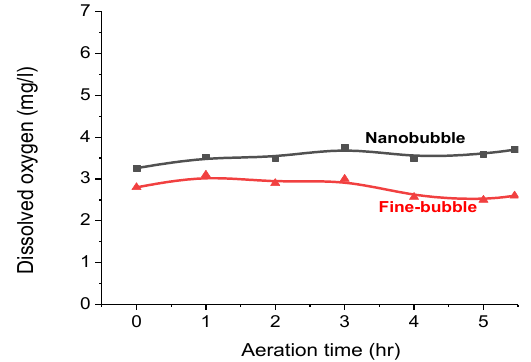
Fig. 4. Changes in Dissolved Oxygen in Reactor Mixed Liquor (SRT=20 d, COD=400